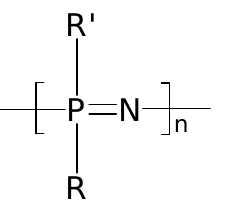
Figure 1. Generic structure of poly[(organo)phosphazenes].